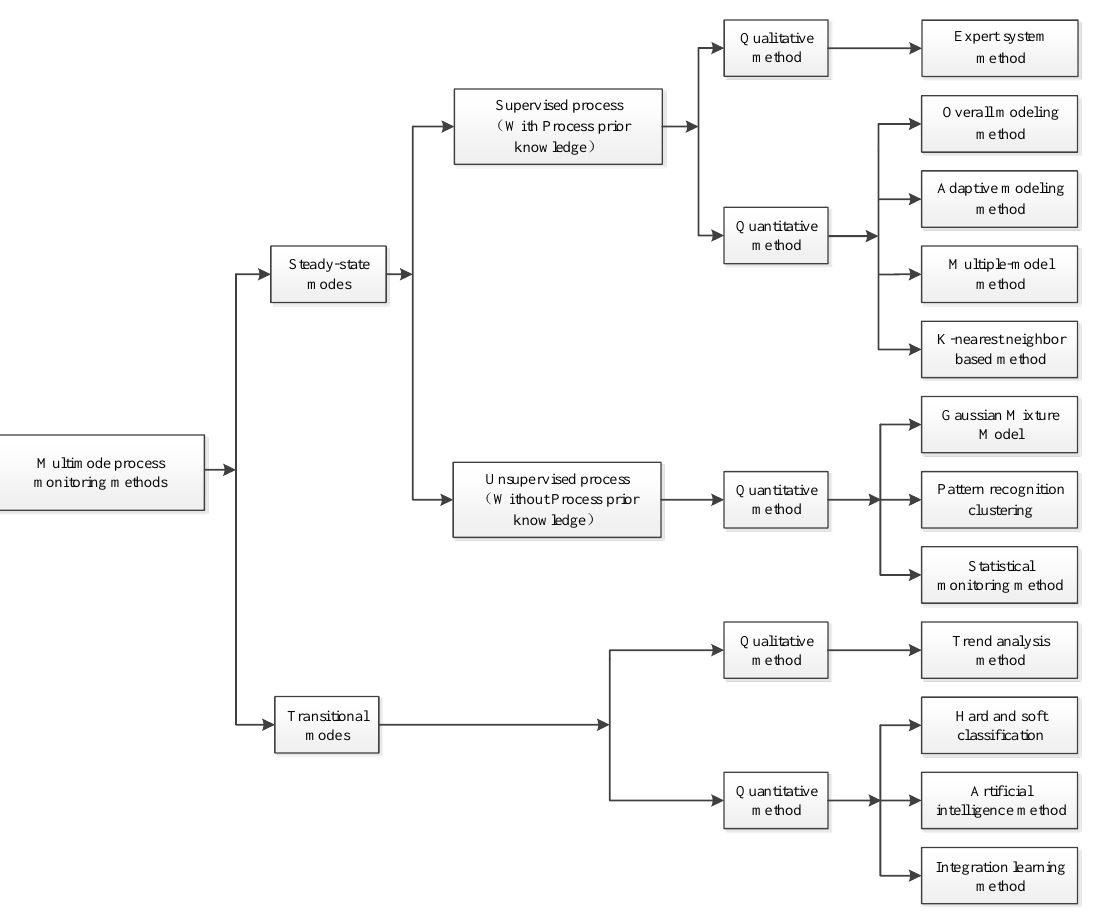
Figure 1. A classification framework for multi-mode process monitoring methods.